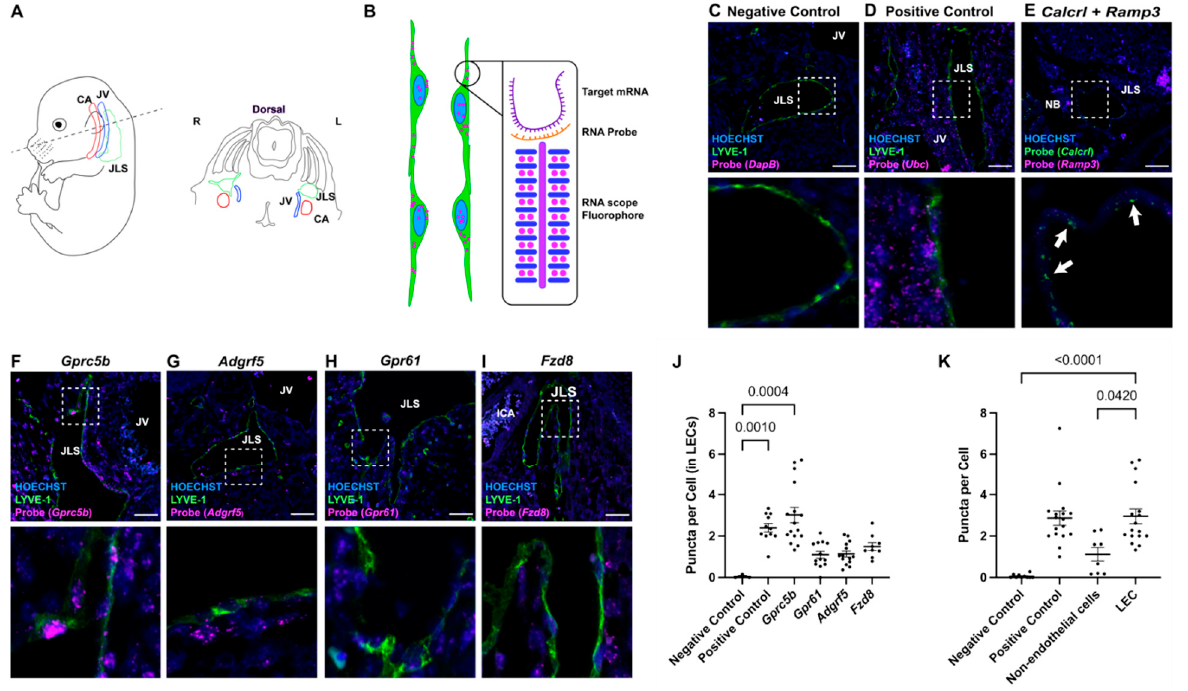
Figure 1. In situ localization of lymphatic endothelial cell-enriched GPCR expression. ( A ) Schematic diagram of E14.5 transverse section of mouse embryo depicting the sterotypic positioning of carotid artery (CA), jugular vein (JV) and jugular lymph sac (JLS). ( B ) Schematic diagram of RNAscope probe design, illustrating how a single mRNA molecule is amplified into a visible fluorophore puncta within a cell. ( C – I ) RNAscope images for indicated probes (magenta), Hoechst nulcei (blue) and the lymphatic maker LYVE-1 or Calcrl in panel ( E ) (green). Probe names are listed at top of images. Lower images are higher magnification views of the white dashed inset. White arrows in ( E ) point to lymphatic endothelial cells with double-labeling of the lymphatic GPCR, Calcrl (green) and Ramp3 (magenta). Scale bars = 50 µm. ( J ) RNAscope quantification for each orphan receptor probe in lymphatic endothelial cells and ( K ) RNAscope quantification for Gprc5b in various tissue types. Puncta per cell is a relative measure of the number of mRNA transcripts for the target gene. Non-endothelial cells (non-ECs) represent all background cells. LEC = lymphatic endothelial cells. Significance calculated using Kruskal–Wallis nonparametric analysis of variance with Dunn’s multiple comparisons test. p -values equal to or less than 0.05 are shown.